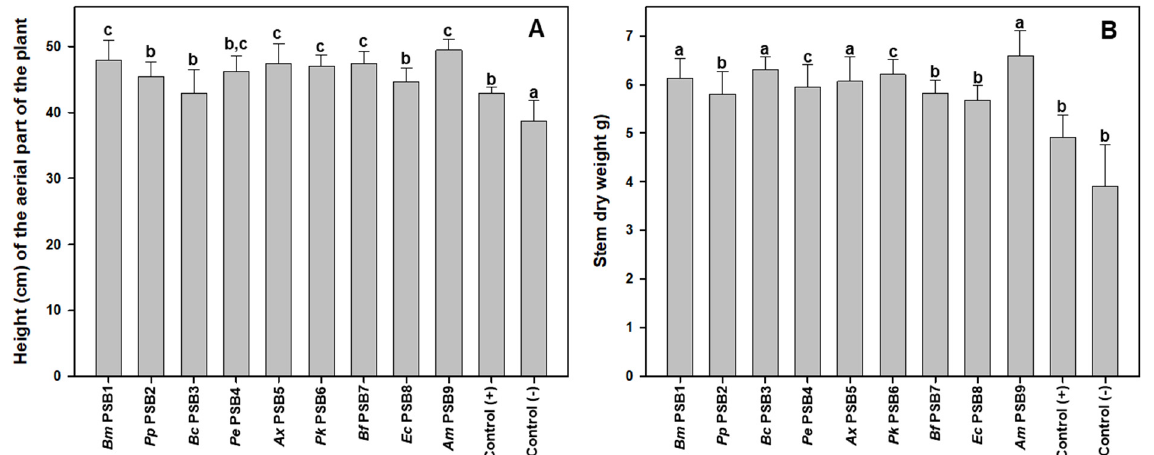
Figure 3. Growth data of barley plants inoculated with different PSB strains: height of the aerial part of the plant ( A ), and stem dry weight ( B ). Data shown correspond to the average of 9 replicates and each replica consisted of 10 plants sown per pot. Bars marked with the same letter are not significantly different ( p ≥ 0.05).